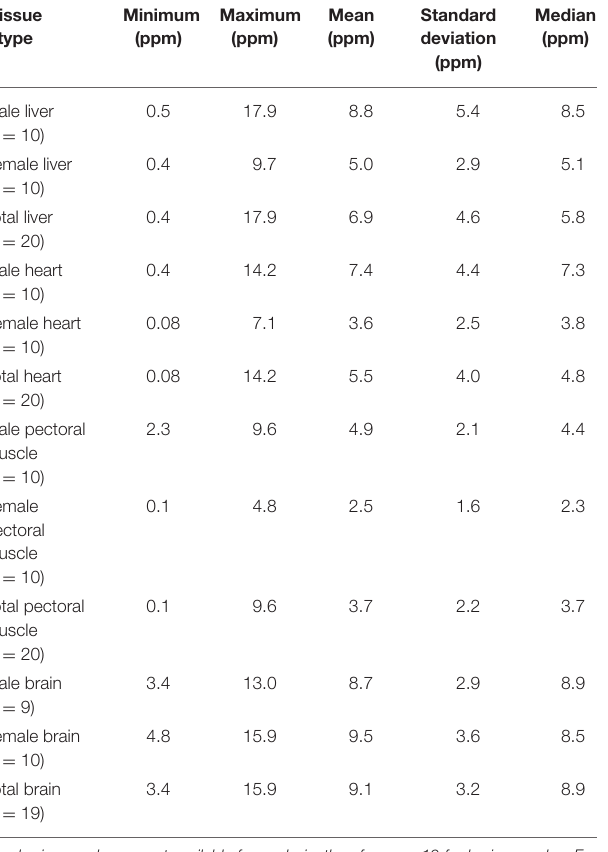
TABLE 2 | Summary statistics for α -tocopherol wet mass concentrations in liver, heart, pectoral muscle, and brain samples from after-hatch year Anna’s Hummingbird carcasses ( n = 20).